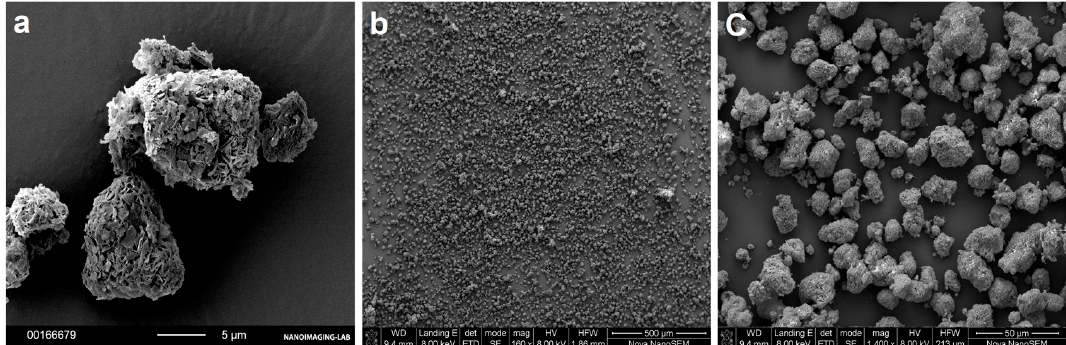
Figure 4. SEM images used for visual analysis of drug-loaded FCC. ( a ) The surface lamella of the unloaded FCC particles can be seen. ( b ) Representative overview of the powder formulation with the highest loaded material (D20N20), showing the absence of agglomerates and external crystals. ( c ) Formulation D20N20 showing preserved lamellar structure of FCC after loading.